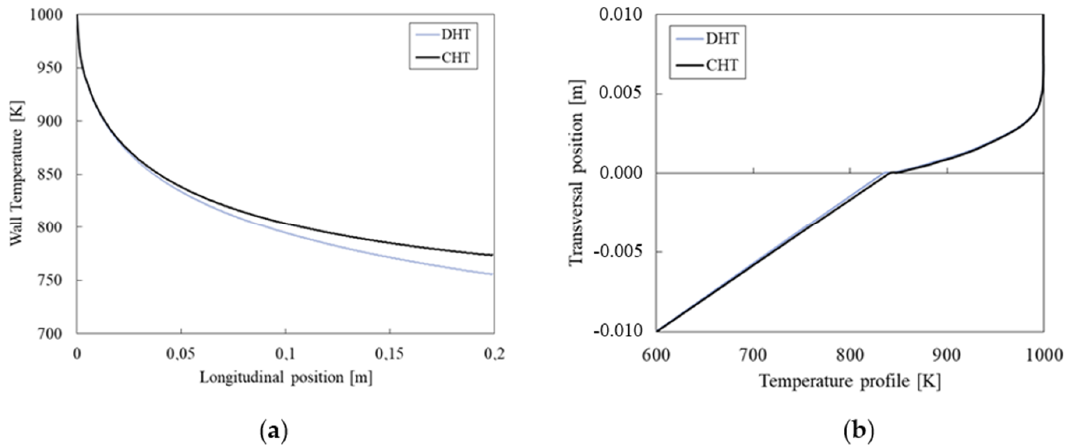
Figure 10. CHT problem for flat plate: ( a ) temperature at the domain interface, ( b ) temperature profile at x = 0.05 m. Numerical vs. analytic solution.